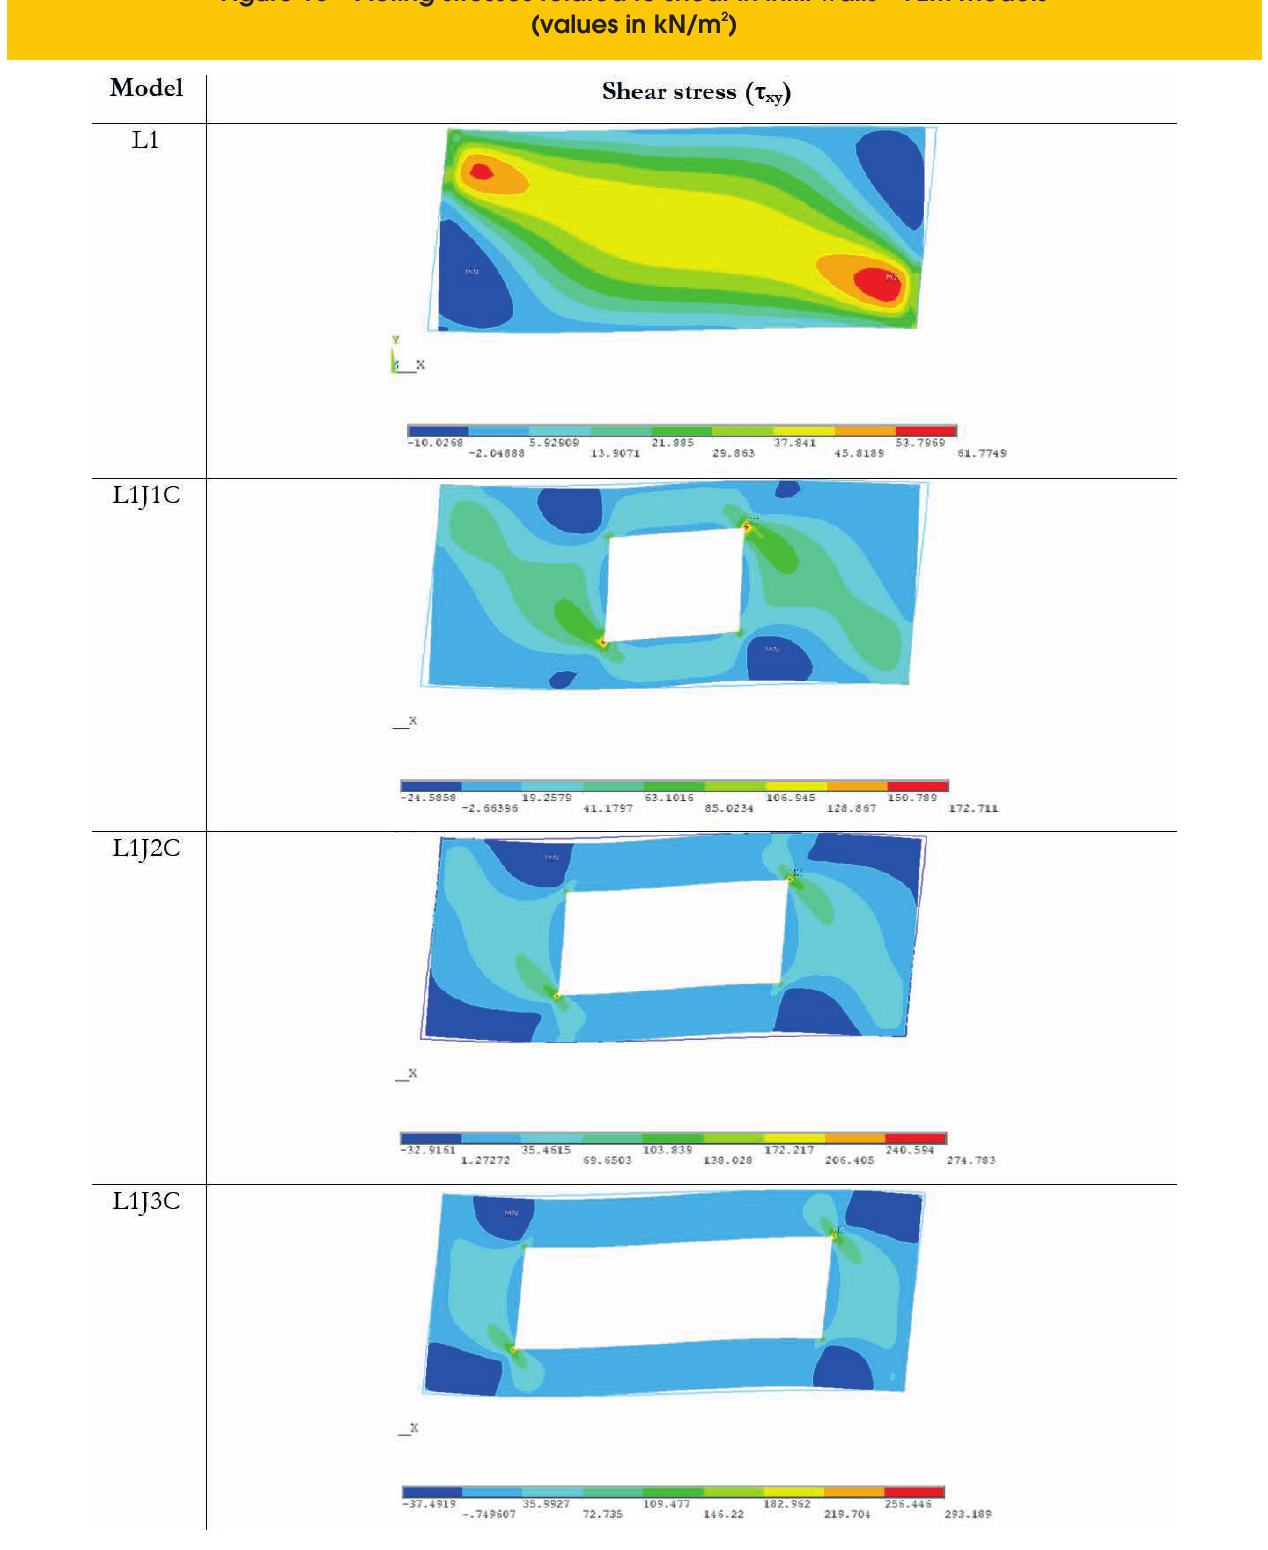
Figure 10 – Acting stresses related to shear in infill walls – FEM models